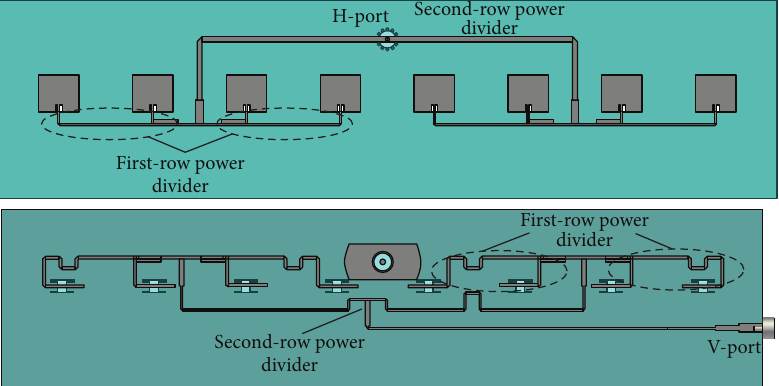
Figure 3: The layout of the 1 × 8 array using the compact feeding networks.